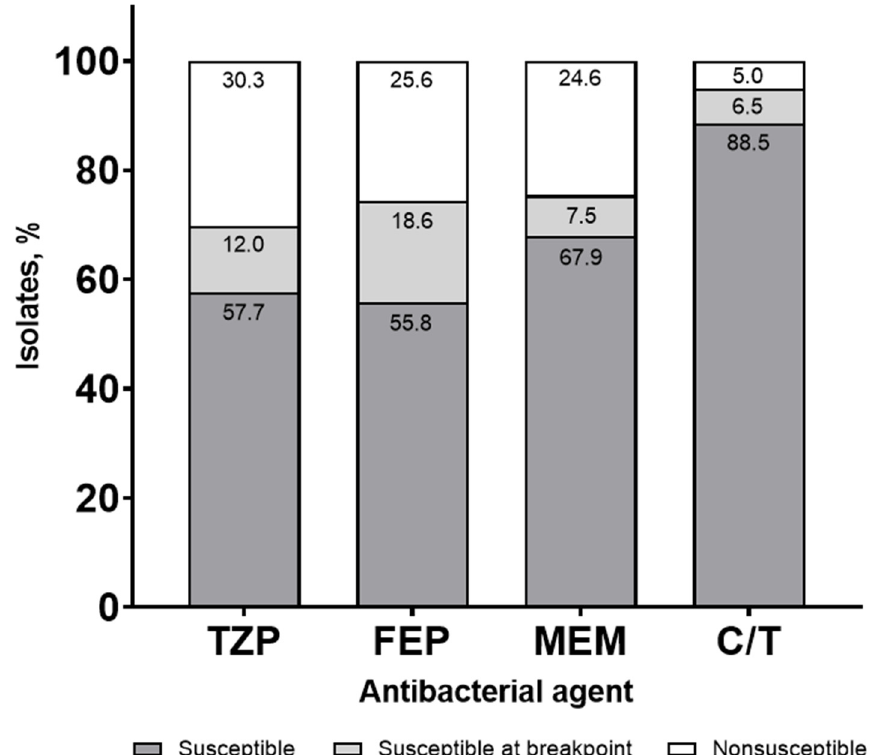
Figure 1. Syndromic antibiogram evaluating susceptibility for Pseudomonas aeruginosa , including isolates susceptible at the minimum inhibitory concentration (MIC) breakpoint collected from a blood or respiratory source. TZP, piperacillin/tazobactam; FEP, cefepime; MEM, meropenem; C/T, ceftolozane/tazobactam.